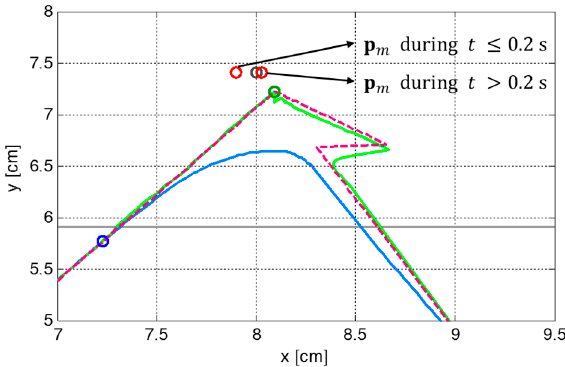
Figure 8. Variation in the modifiable ZMP position, 𝐩 (cid:3040) , as well as CP and COM trajectories, 𝛏 (cid:3045)(cid:3032)(cid:3033) , 𝛏 (cid:3030) ,